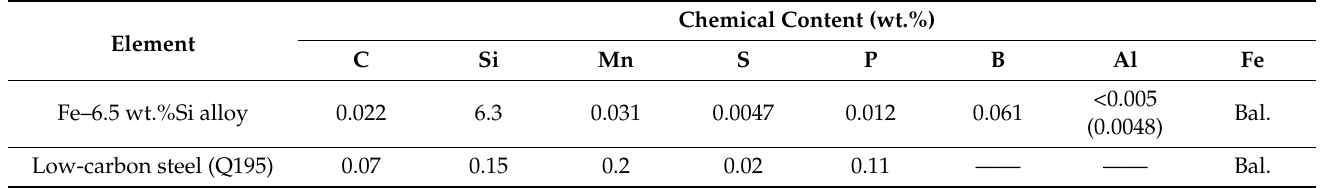
Table A1. The material compositions of Fe-6.5wt.%Si alloy and low-carbon steel.